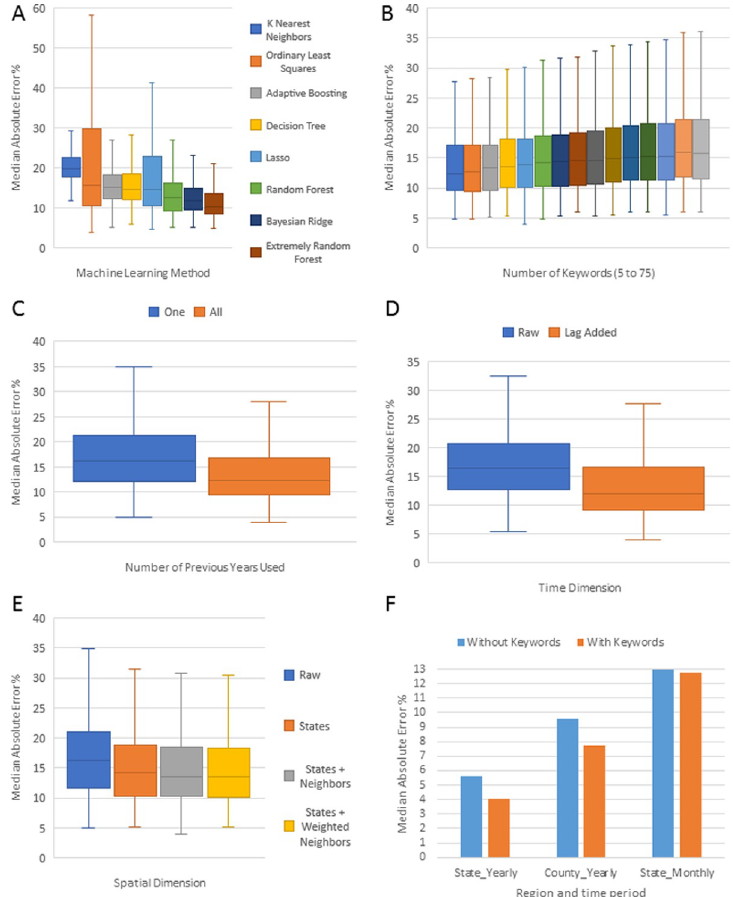
Fig 4. Machine learning performance in the working dataset. (A) Machine Learning Methods; (B) Number of top keywords used (from 5 to 75, in steps of 5); (C) Number of previous Years Used; (D) Inclusion of lag observed ODD rate; (E) Inclusion of spatial variables; (F) Comparison of the final model’s performance in 2017 with and without Web-search Terms.